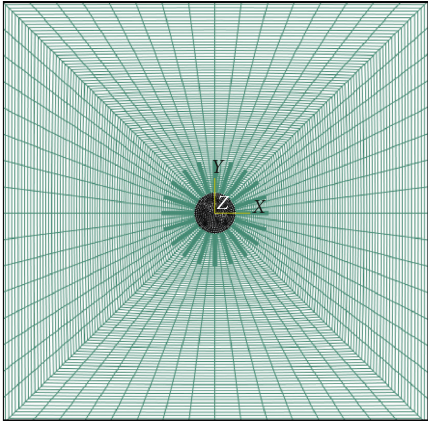
Figure 5: Finite element model of surrounding rock in anchorage roadway.